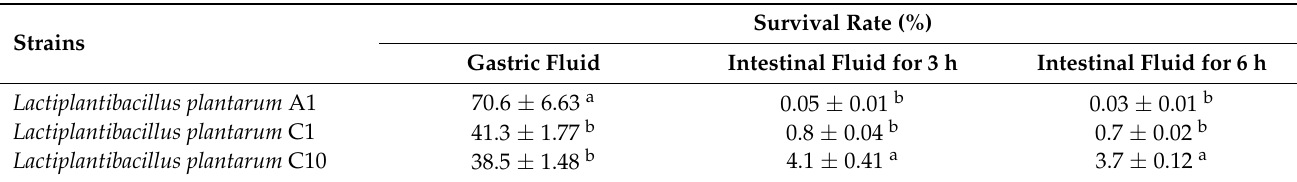
Table 7. Viability of the LAB strains after exposure to simulated gastric and intestinal fluids.